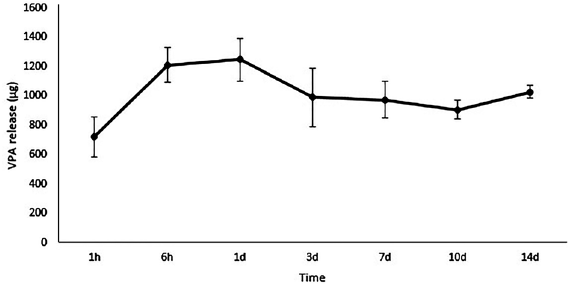
Figure 3. Cumulative release pro fi le of valproic acid (VPA) from core-shell fi bers determined by high performance liquid chroma- tography. Data are reported as means and SD. The experiments were performed in triplicate.